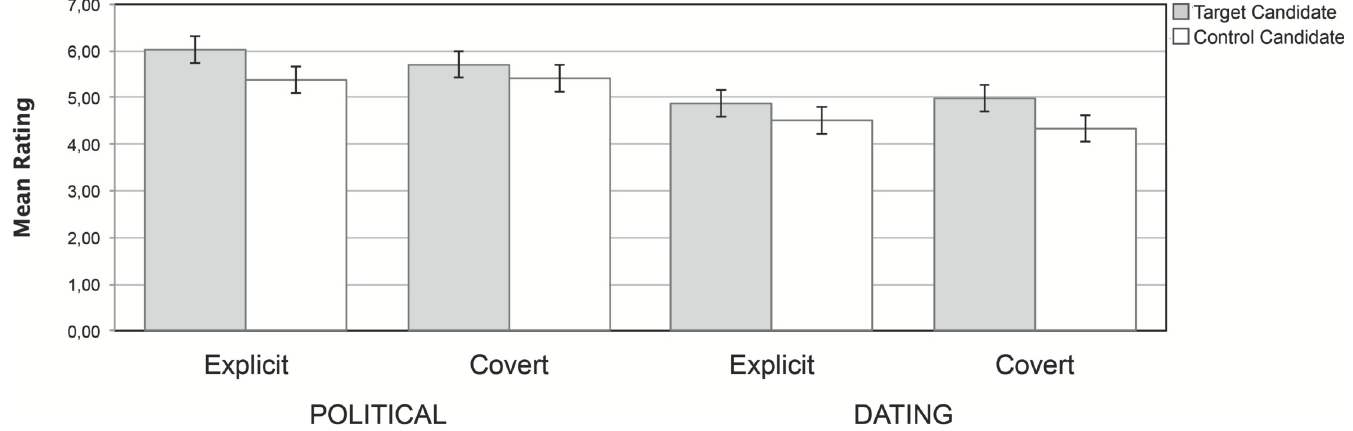
Fig 3. Mean preference for target and control candidates, for each group and context in Experiment 4. Error bars represent 95% CI.